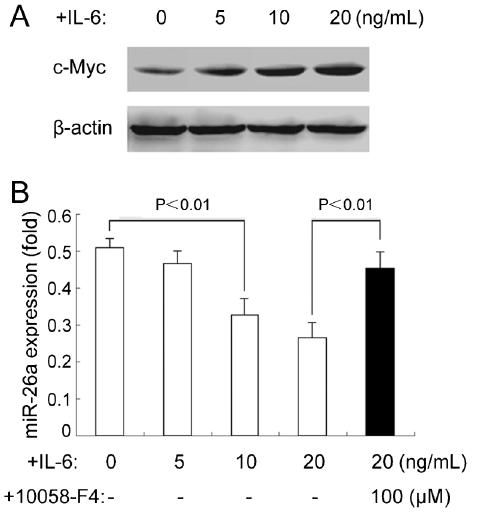
Figure 3. IL-6 stimulation leads to the reduction of miR-26a expression via activation of c-Myc in HepG2 cells. A , Representative immunoblots showed that c-Myc protein in HepG2 cells was increased in a dose-dependent manner upon IL-6 stimulation. b -actin was used as an internal control. B , Quantitative RT-PCR showed that miR-26a expression was reduced upon IL-6 stimulation, and the reduced miR-26a expression could be blocked by a c-Myc inhibitor (10058-F4). The data are representative of five independent